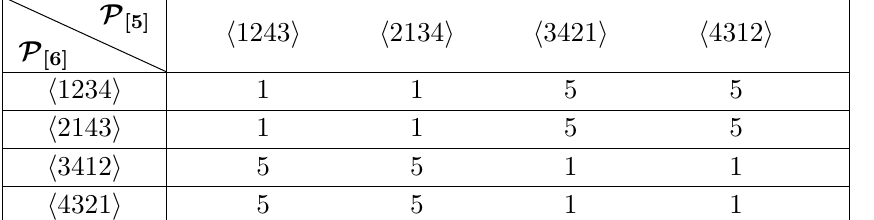
Table 11. {P} 6 − {P} 5 two-point correlator values.